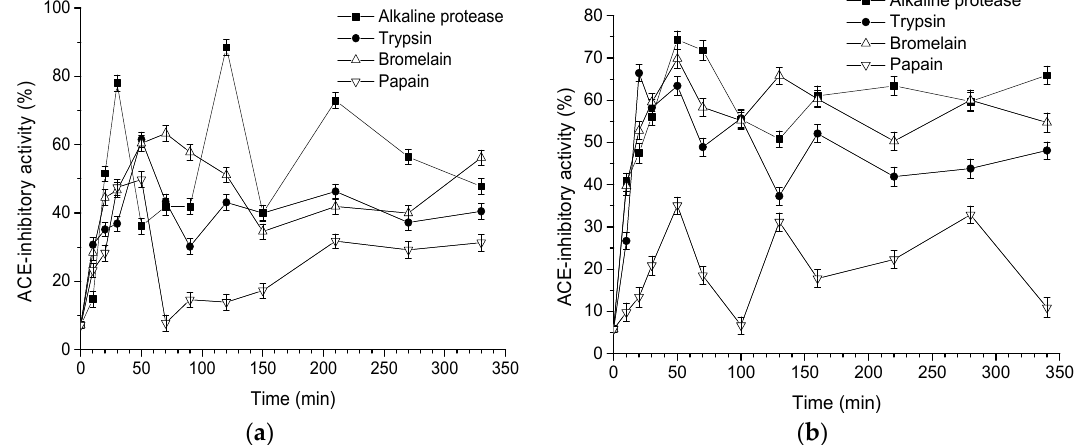
Figure 2. Influence of four proteases on the angiotensin I-converting enzyme (ACE)-inhibitory activity of hydrolysates from skimmed milk: ( a ) goat milk and ( b ) cow milk. The error bars represent standard deviation of means ( n = 3).